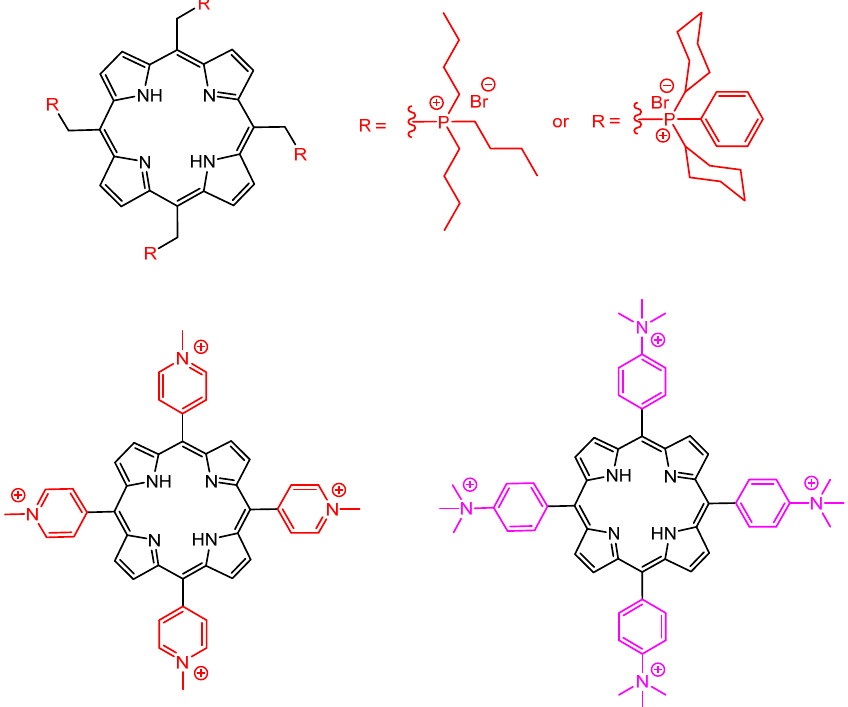
Figure 8. Molecular structures of tetra-cationic porphyrin derivatives used against Leishmania major promastigotes, reported by Bristowa et al. [116].